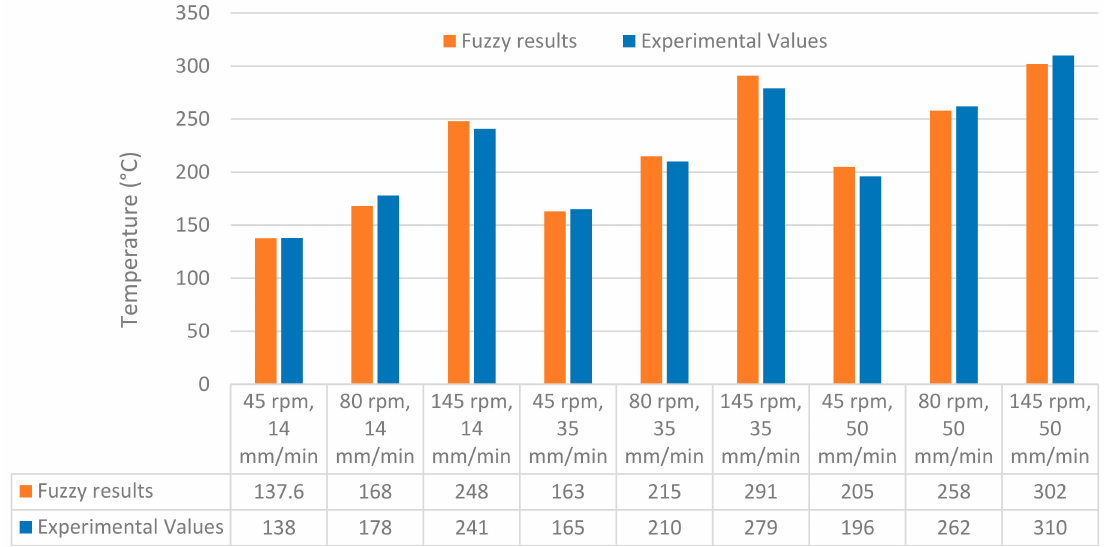
Figure 12. Comparison of fuzzy and experimental